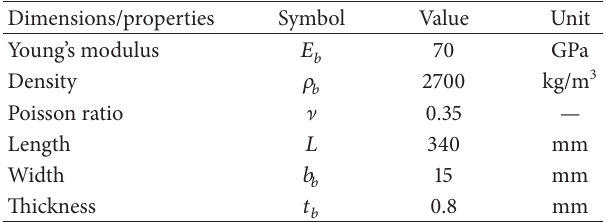
Table 1: Beam’s dimensions and properties.